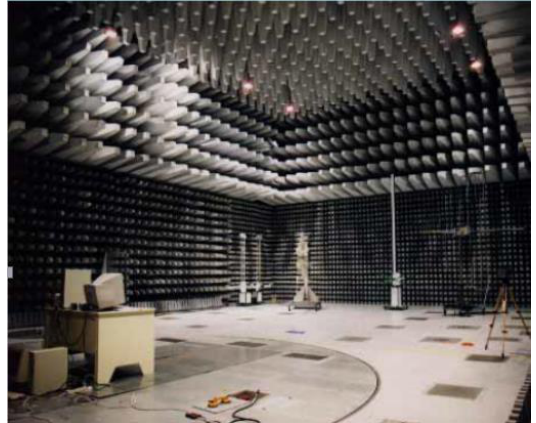
Figure 10. Schematic diagram of the 10 m chamber.